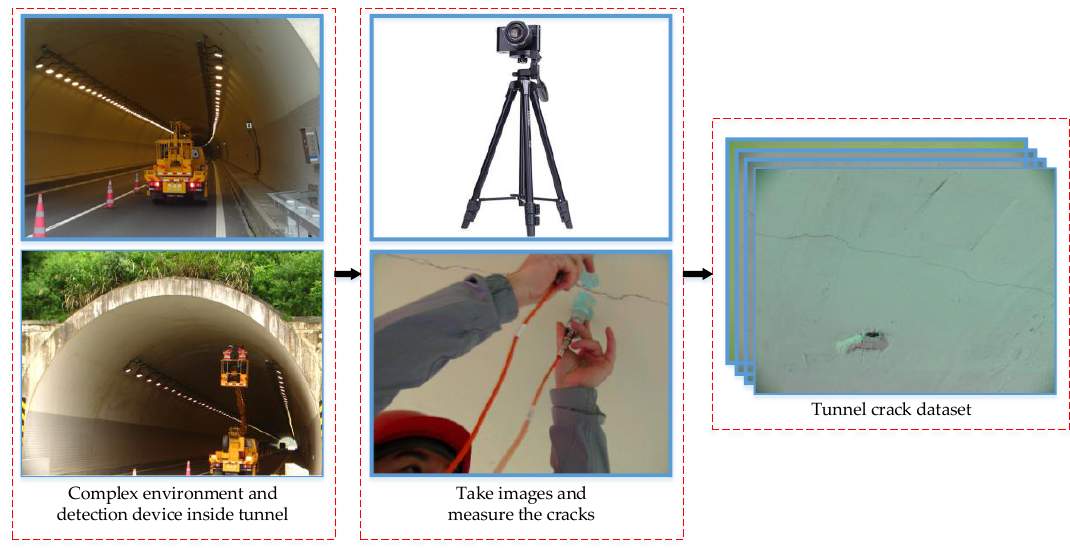
Figure 8. Schematic diagram of the tunnel crack image acquisition mechanism.